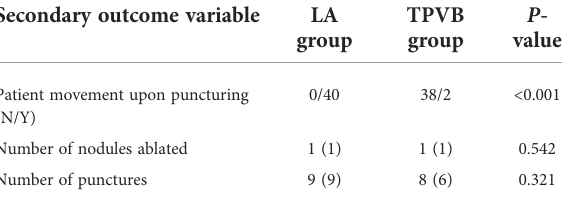
TABLE 3 Comparison of patient ’ s movements, number of nodules ablated, and number of punctures between the two